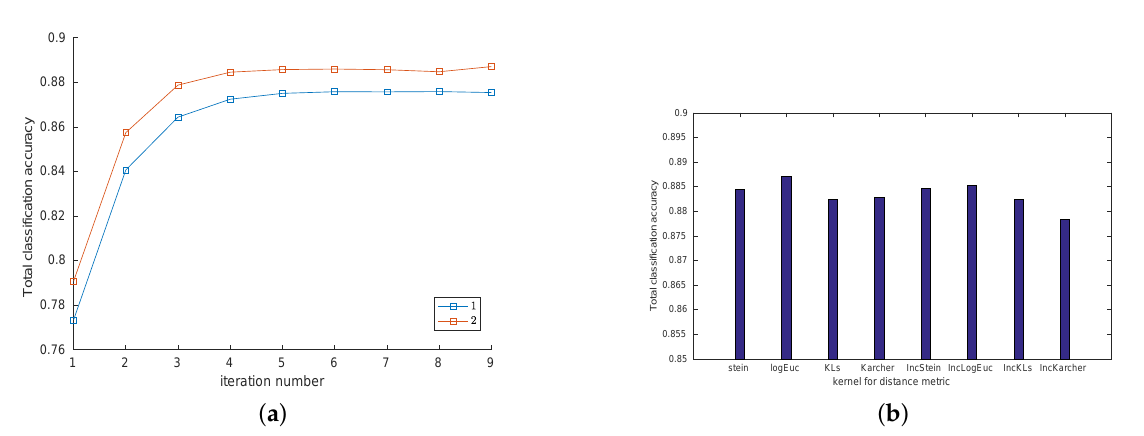
Figure 14. Classification accuracy versus varying norms and distance metrics. ( a ) accuracy under different norm regulariza- tion. ( b ) total classification accuracy under different distance